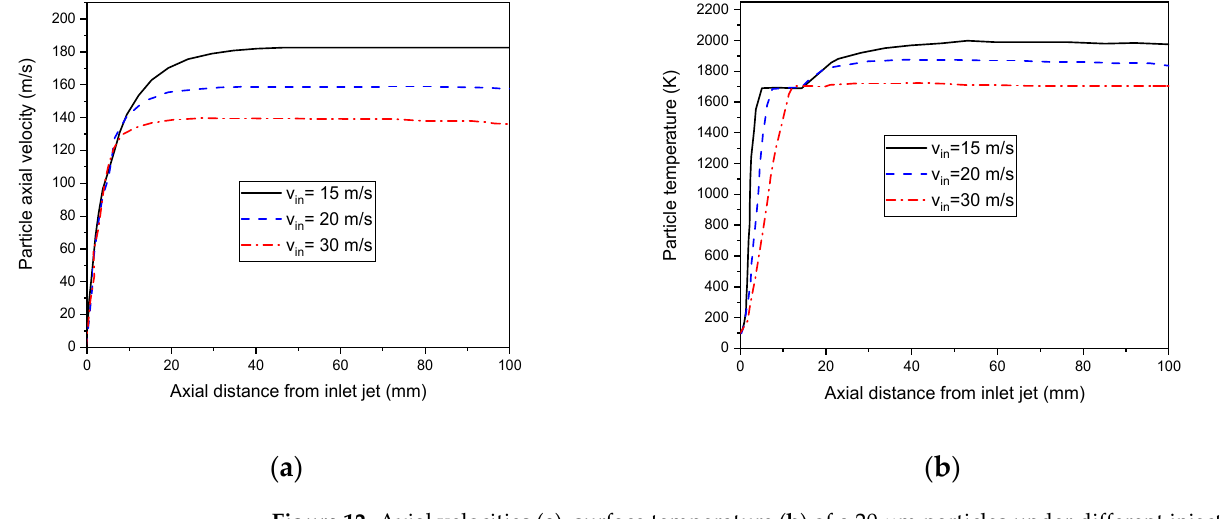
Figure 11. Silicon particles trajectory along the plasma jet (N p = 10,000, d p = 20 µ m, and v in = 20 m/s).